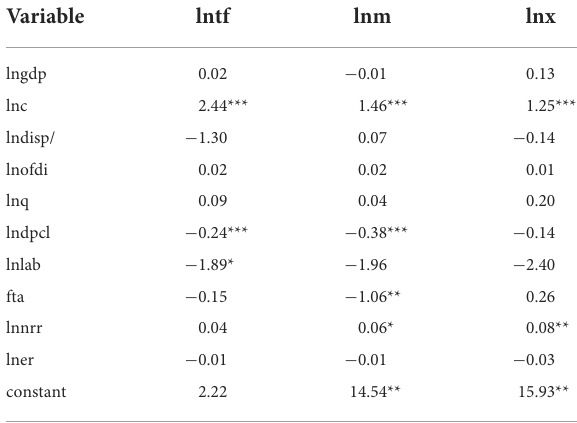
TABLE 1 Panel data description statistics. TABLE 2 Regression analysis